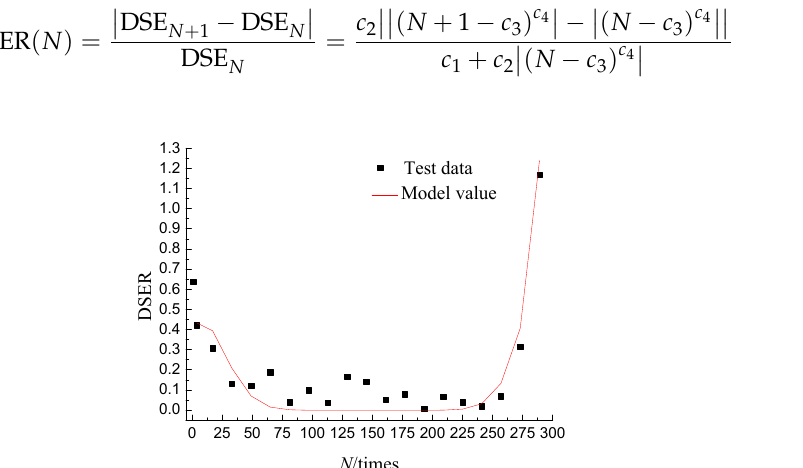
Figure 9. Contrast result of dissipated strain energy ratio (DSER).